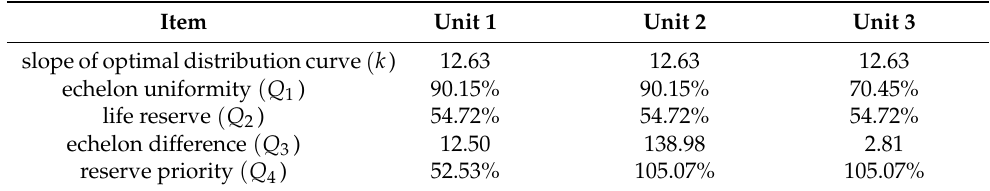
Table 2. Calculation results.